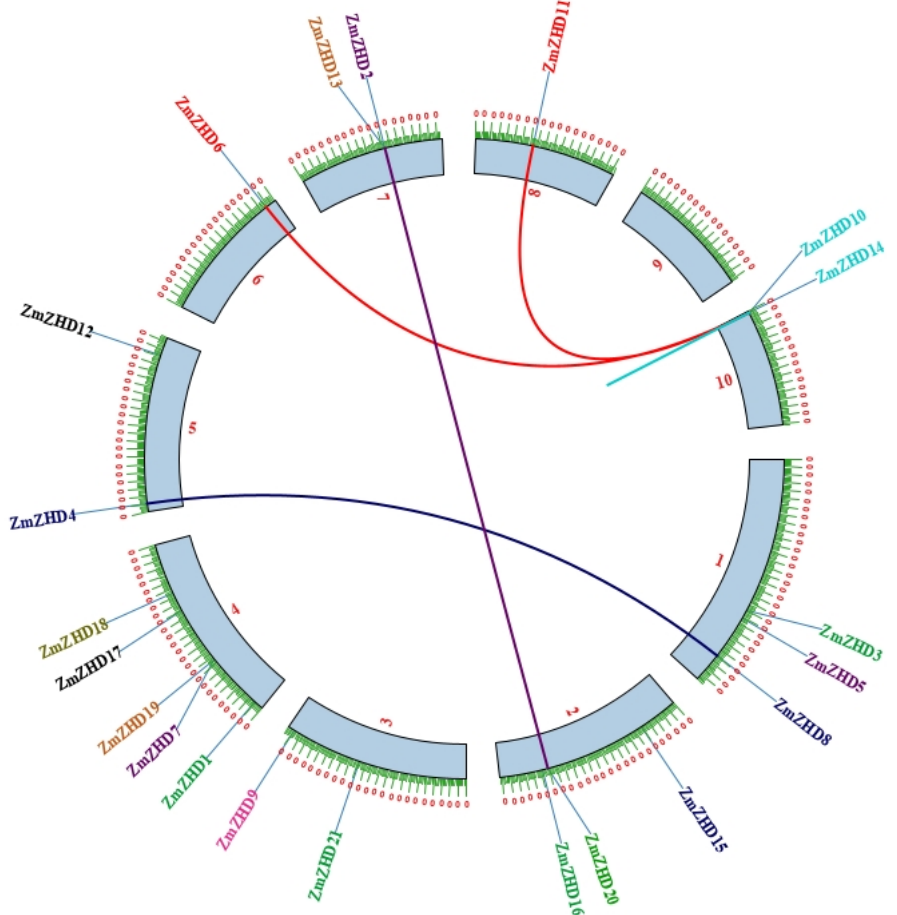
Figure 5. Chromosomal distribution and inter-chromosomal relationships of ZmZHD genes. Red lines connect duplication gene pairs between ZmZHD10 and ZmZHD11 and between ZmZHD6 and ZmZHD10 ; blue lines connect duplication gene pairs between ZmZHD4 and ZmZHD8 , and violet lines connect duplication gene pairs between ZmZHD2 and ZmZHD20 .